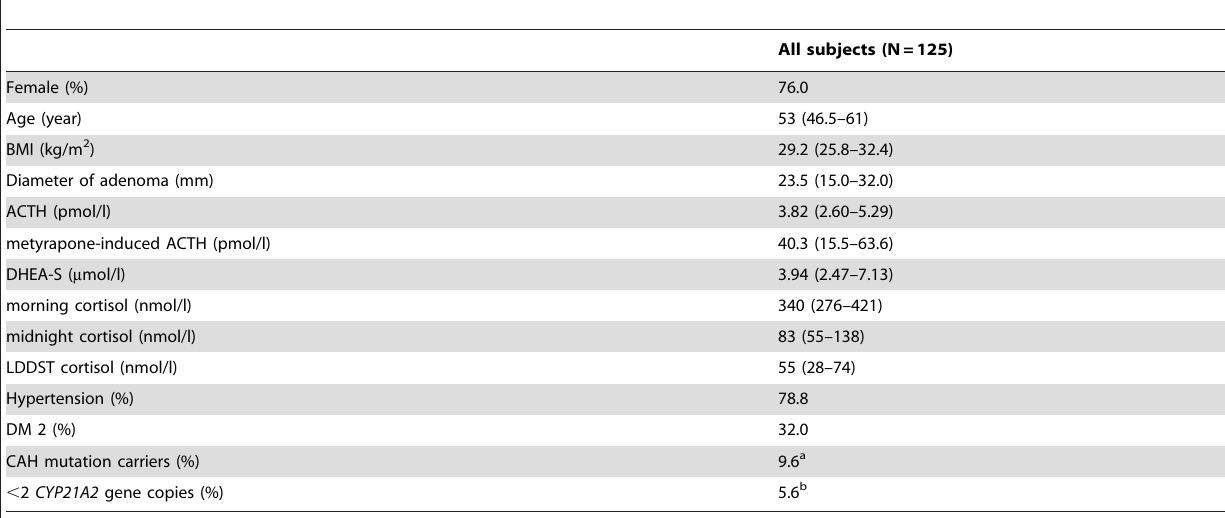
Table 1. Characteristics of Hungarian subjects with non-functioning adrenal incidentaloma before genetic